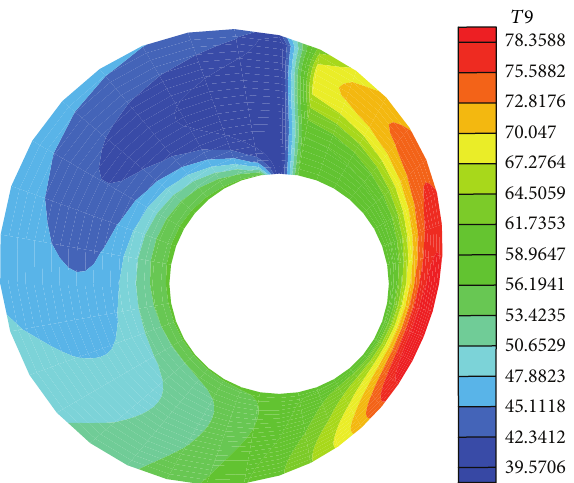
Figure 7: Isothermal lines of the journal bearing at its central plan for 𝑁 = 3000 rev./min and 𝑛 = 1 .